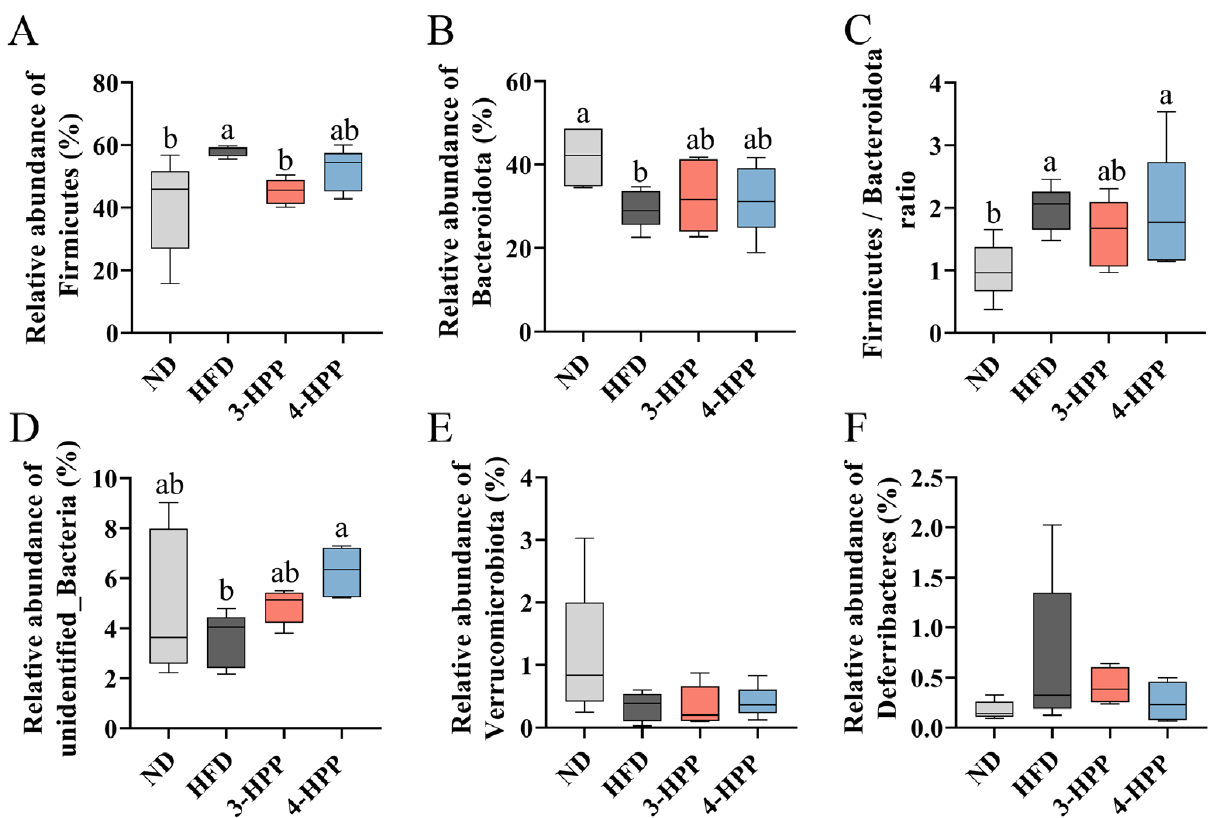
Figure 5. The effects of 3 − HPP and 4 − HPP on the relative abundance of gut microbiota at the phylum level. Relative abundance of Firmicutes ( A ), Bacteroidetes ( B ), unidentified_Bacteria ( D ), Verrucomicrobita ( E ), and Deferribacteres ( F ). ( C ) The ratio of Firmicutes to Bacteroidetes . Data are expressed as means ± SDs. n = 5 if not specified. According to Duncan’s test, mean values with different letters denote significant differences at p < 0.05.